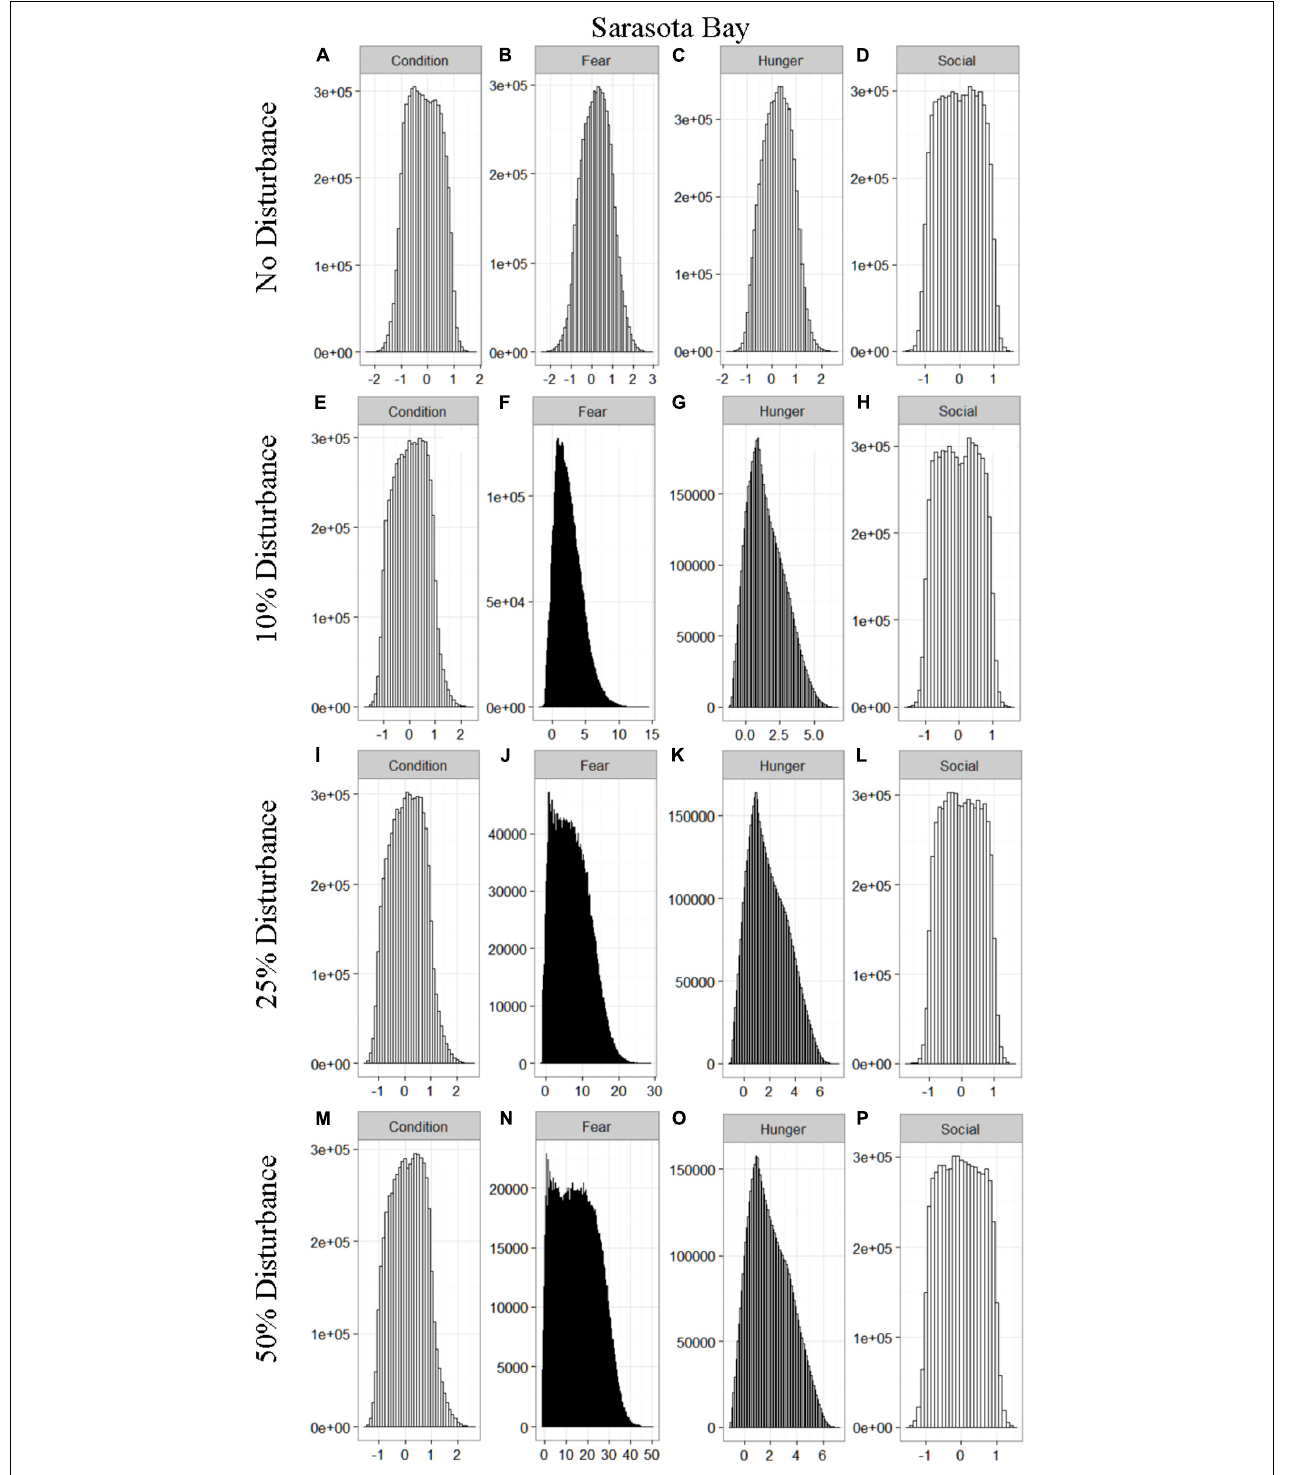
FIGURE 3 | The four motivational states of condition (A,E,I,M) , fear (B,F,J,N) , hunger (C,G,K,O) , and social need (D,H,L,P) for the simulated Sarasota Bay population under each of the four disturbance scenarios: no disturbance (A–D) and a 10% (E–H) , 25% (I–L) , or 50% (M–P) chance of an individual being disturbed when in the area used by whale-watching vessels. The y -axis is the cumulative count over all simulations, while the x -axis is a unit-less measure of individual motivation. Motivation is centered at zero (i.e., indifference) and can take on negative values to indicate a lack of incentive (i.e., satisfaction) and positive values to indicate strong incentive (i.e., discontent) (New et al.,